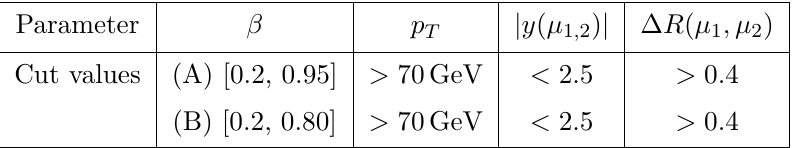
Table 1 . Basic selection cuts applied to analyze signals of heavy stable charged